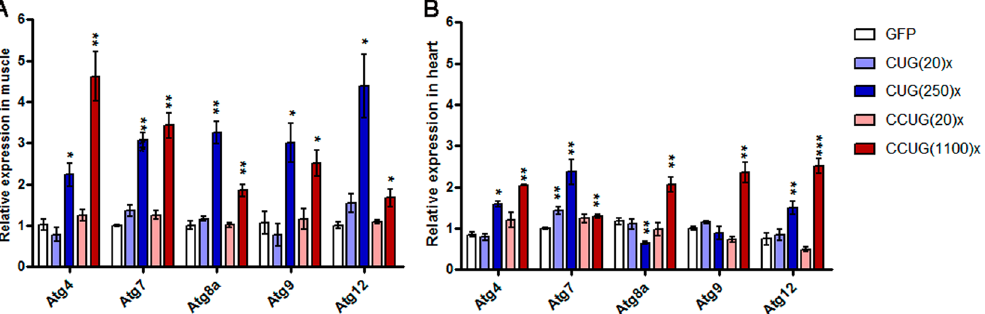
Figure 3. The expression of autophagy-related genes is upregulated in flies expressing expanded CUG or CCUG repeats in muscle or heart. Relative expression levels of Atg4 , Atg7 , Atg8a , Atg9 and Atg12 measured by qRT-PCR in muscle (Mhc-Gal4 driver; A ) and heart samples (GMH5-Gal4 driver; B ), showed a significant upregulation of these autophagy-related genes in flies expressing expanded CUG (CUG(250) × ) or CCUG repeats (CCUG(1100) × ). The histograms show the mean ± SEM. * p < 0.05, ** p < 0.01, *** p < 0.001 (Student’s